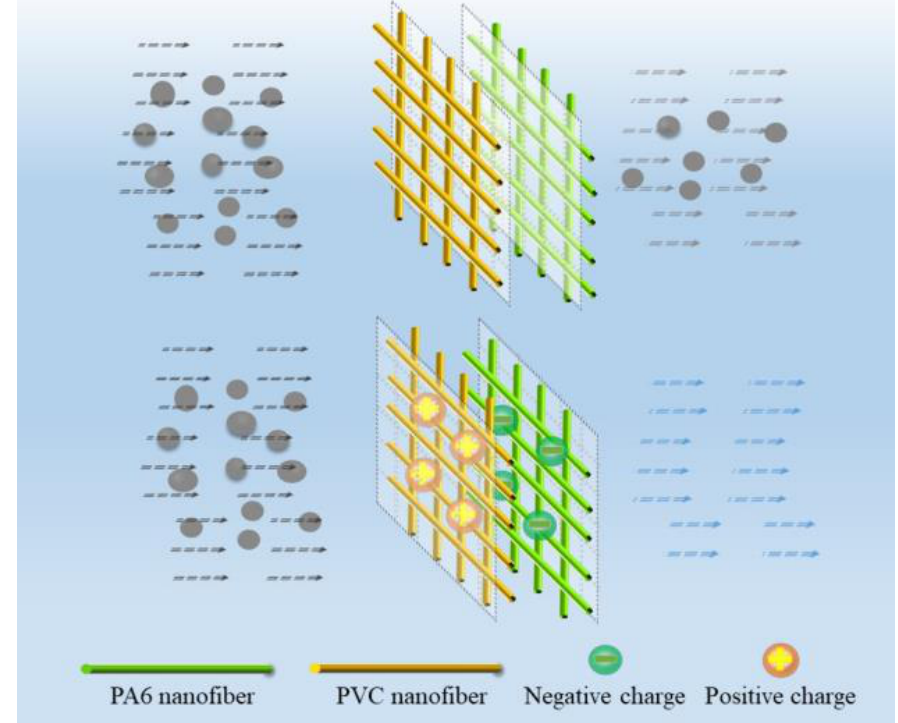
Figure 1. Schematic diagram for the air filtration process of the self-powered composite membrane.